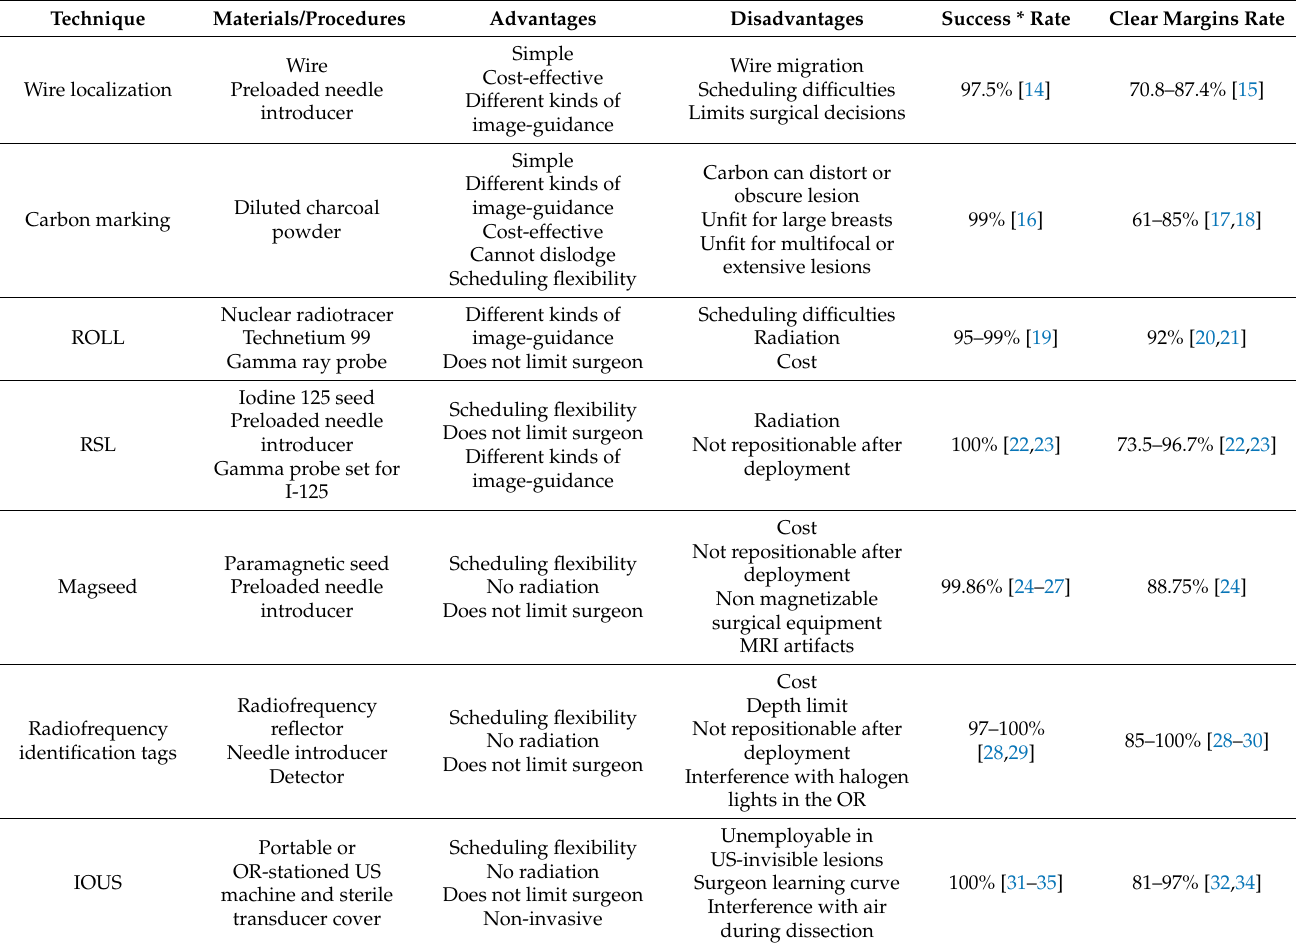
Table 1. Comparison of different localization techniques. Abbreviations: ROLL = radio-guided occult lesion localization; RSL = radioactive seed localization; Magseed = magnetic seed localization; IOUS = intraoperative ultrasound; Skin tattoo = preoperative localization with skin tattoo; OR = operating room; US = ultrasound; MRI = magnetic resonance imaging. * Success is defined as removal of target lesion. ** Authors’